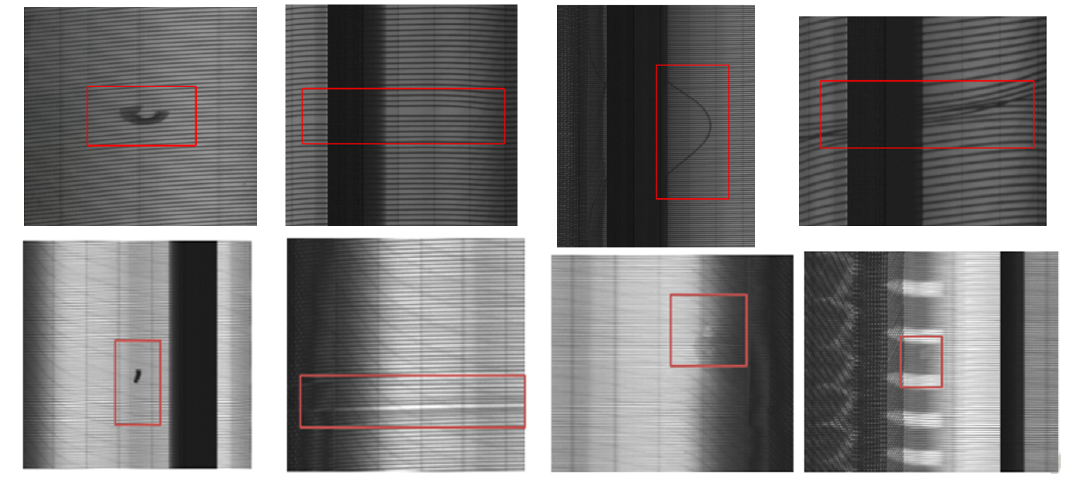
Figure 3. Typical defects in tire X-ray